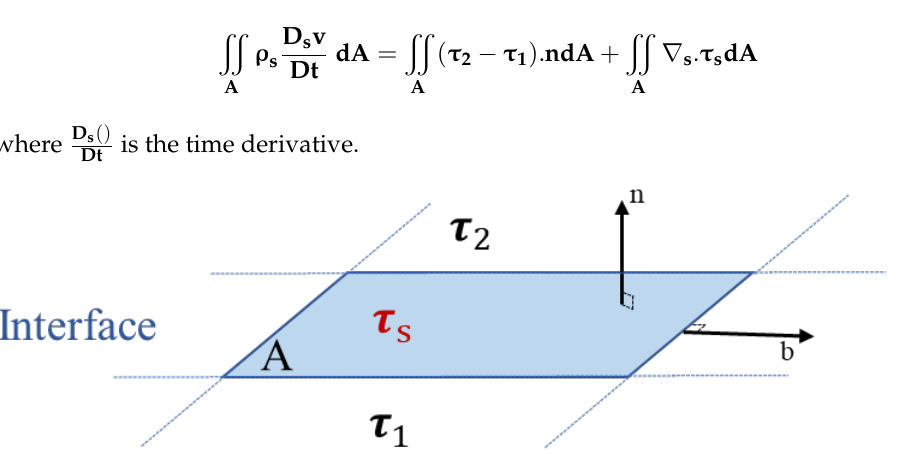
Figure 4. The surface element A separated two fluids denoted 1 and 2. The unit vectors normal and tangential to the surface are denoted by n and b , respectively.